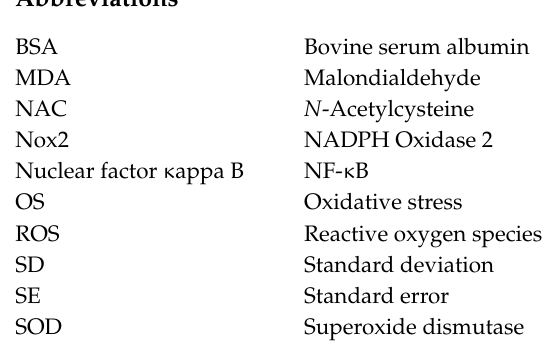
Table S1: E ff ects of NAC on oxidative stress parameters and antioxidant enzymes in C57 BL / 6 and Bla / J mice, Table S2: E ff ect of NAC supplementation on muscle strength in C57 BL / 6 mice and Bla / J